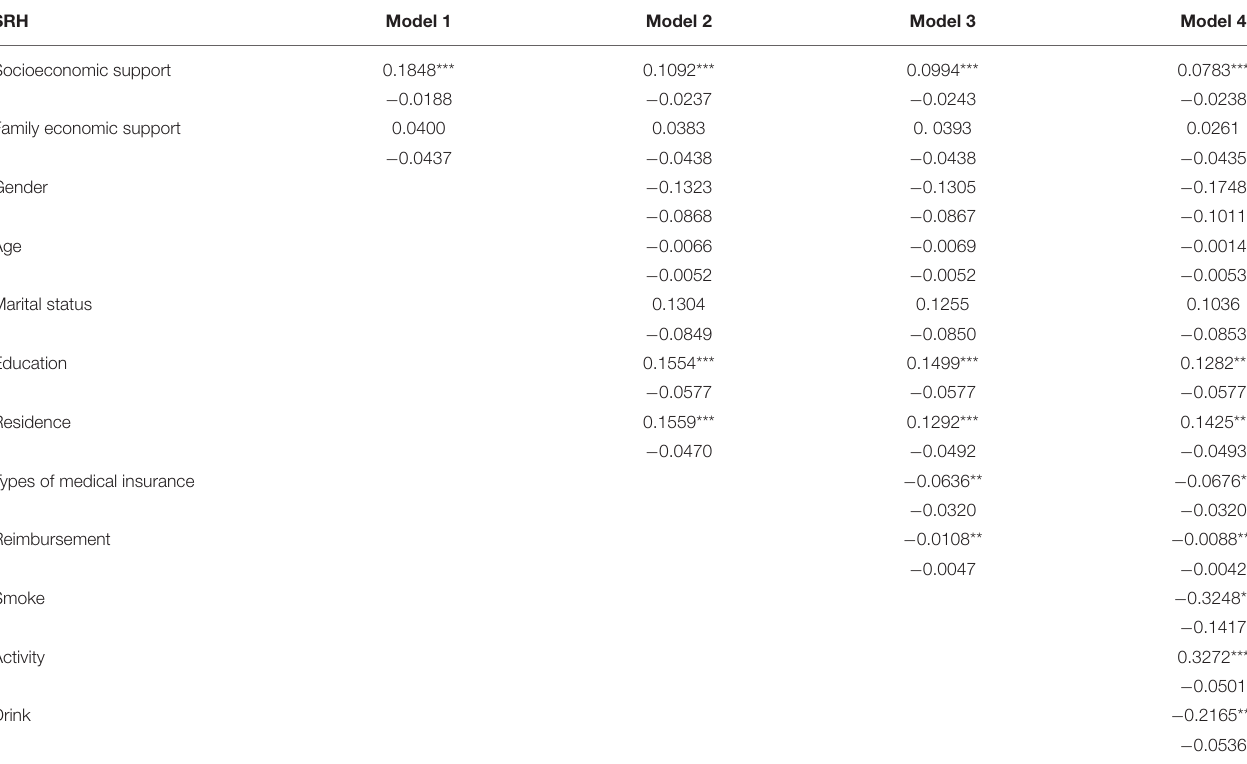
TABLE 3 | SRH stepwise regression